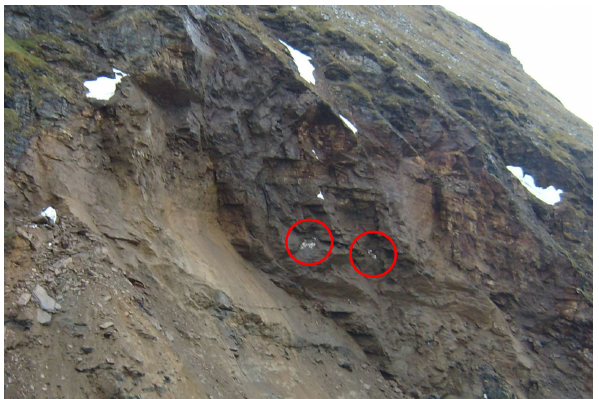
Figure 2. Visible in situ ice (encircled areas) observed in the rock avalanche failure zone on 26 June 2008. The photograph was taken a few hours after the event (Photograph by courtesy of Kjetil Brat- tlien,